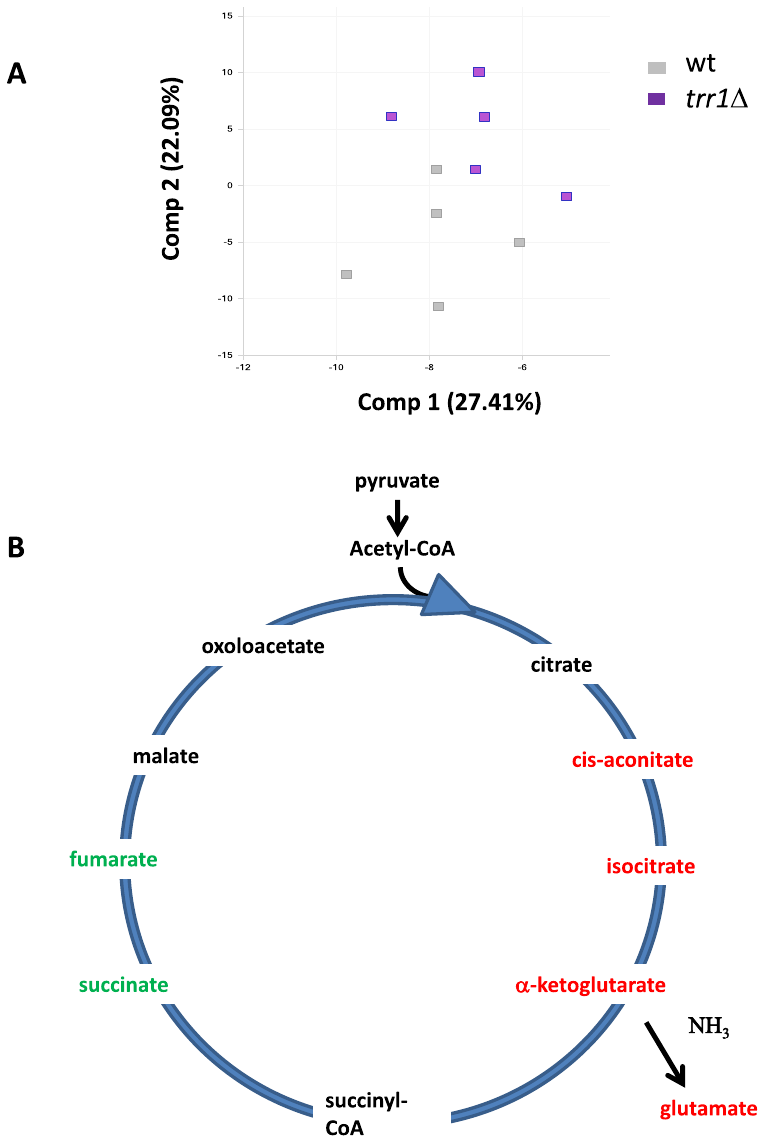
Figure 3. The TRR1 deletion causes a global metabolomics alteration. ( A ) The PCA analysis of the metabolomic data of strains C9 and the trr1 Δ mutant during wine making. Five replicas of each strain were tested. Each principal component is a linear combination of every metabolite, and principal components are uncorrelated. The number of principal components equals the number of observations. ( B ) The TCA pathway and its connection to glutamate synthesis. The metabolites up-regulated in trr1 Δ are highlighted in red and the down-regulated metabolites are depicted in